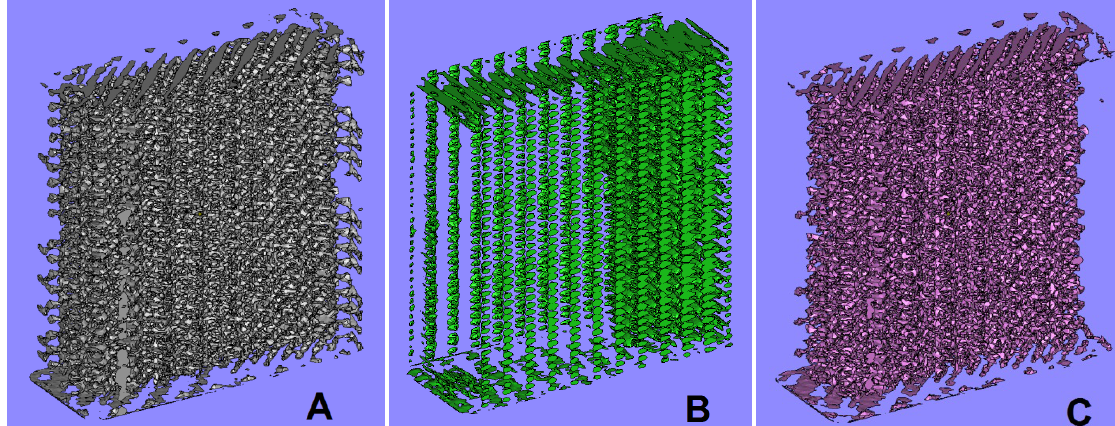
Figure 4: Distribution of the voids in the volume of